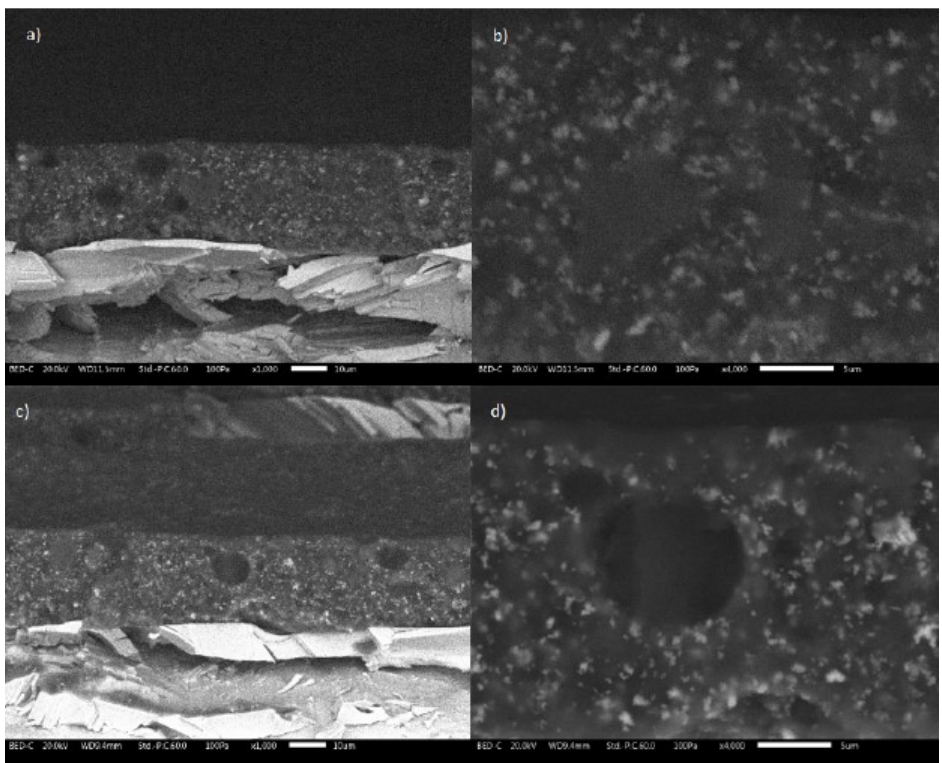
Figure 3. SEM images of red samples. ( a , b ) Images of the Red sample at increasing magnifications. ( c , d ) Images of the Red-N sample at increasing magnifications.